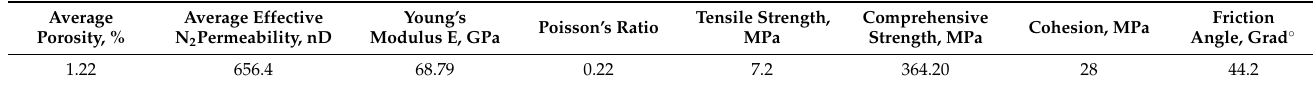
Table 1. Physical properties of rock samples. Average Average Effective Porosity, % N 2 Permeability, nD